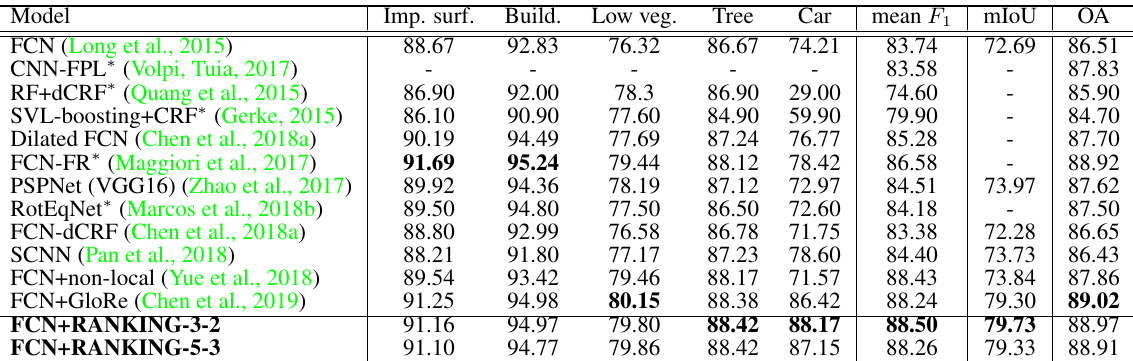
Table 2. Experimental Results on the Vaihingen Dataset